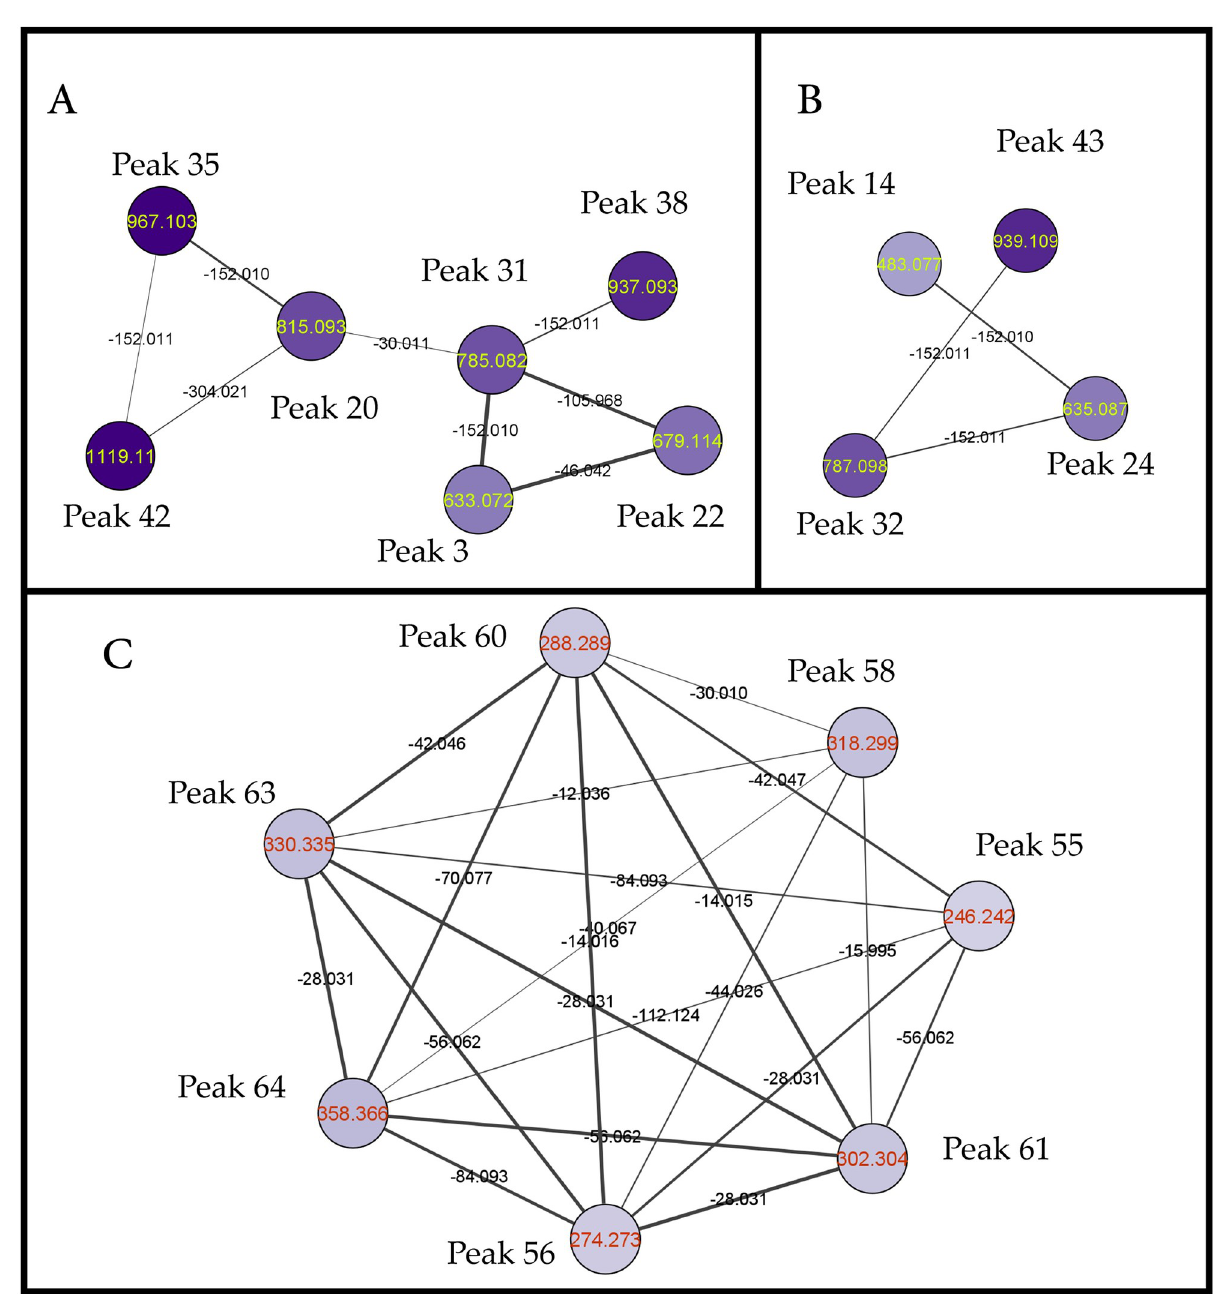
Fig 3. (A) Molecular network group of hexahydroxydiphenoyl hexose derived compounds. Peak numbers are according to that listed in (Table 1) as follows: peak 3; galloyl- O -hexahydroxydiphenoyl hexose, peak 20; methoxy-di- O -galloyl-hexahydroxydiphenoyl hexose, peak 22; ethoxygalloyl- O - hexahydroxydiphenoyl hexose, peak 31; di- O -galloyl-hexahydroxydiphenoyl hexose, peak 35; methoxy-tri- O -galloyl-hexahydroxydiphenoyl hexose, peak 38; tri- O -galloyl-hexahydroxydiphenoyl hexose, peak 42; methoxy-tetra- O -galloyl-hexahydroxydiphenoyl hexose. (B) Molecular network group of sugar polygalloyl esters. Peak numbers are according to that listed in (Table 1) as follows: peak 14; di- O -galloyl-hexoside, peak 24; tri- O -galloyl- hexoside, peak 32; tetra- O -galloyl-hexoside, peak 43; penta- O -galloyl-hexoside. (C) Molecular network group of amino alcohols measured under positive ionization mode. peak numbers are according to that listed in (Table 1) as follows: peak 55; amino-tetradecanediol, peak 56; amino- hexadecanediol, peak 58; amino-octadecanetriol, peak 60; amino-heptadecanediol, peak 61; amino-octadecanediol, peak 63; aminoeicosanediol, peak 64; aminodocosanediol. Nodes are color-coded in the three networks according to their m/z ranges and labelled by their parent ions. Edges are labelled by the mass differences between each node pair where their line widths are related to the cosine score (from thin, cosine score: 0.7, to thick, cosine score: 1).